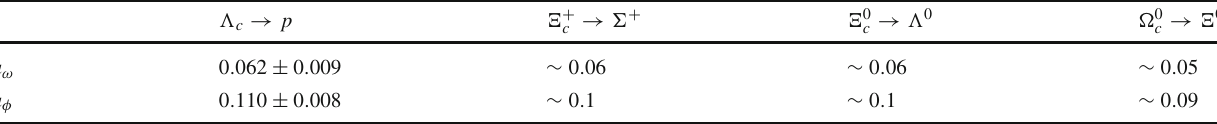
Table 2 Resonance parameters a ω , a φ defined in (3) for various rare charm baryon transitions, see